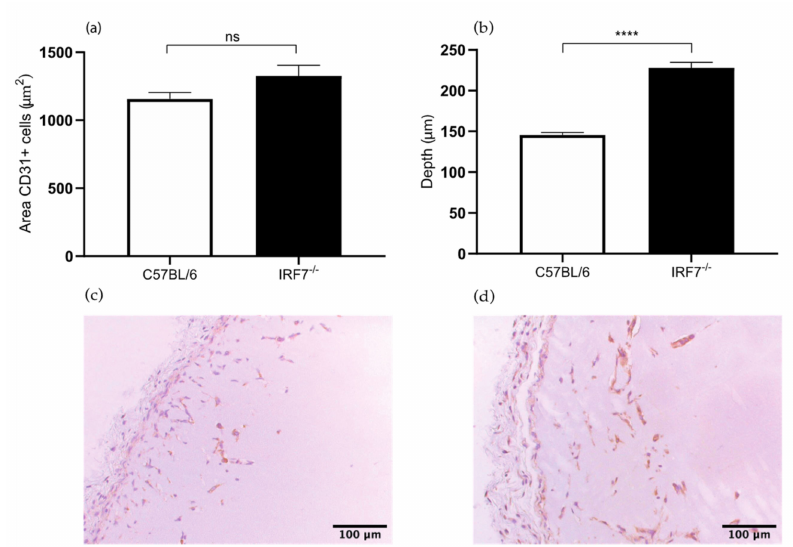
Figure 2. ( a ) Area of CD31 + cells in the subcutaneously injected Matrigel, in IRF7 − / − and wild type C57BL/6 mice. ( b ) Quantification of the depth ( µ m) of ingrowth of CD31 + cells into subcutaneously injected Matrigel, in IRF7 − / − and wild type C57BL/6 mice. ( c ) Immunohistochemical staining of paraffin-embedded Matrigel plug of C57BL/6 7 days after Matrigel injection, using anti-CD31 antibodies. ( d ) Immunohistochemical staining of paraffin-embedded Matrigel plug of IRF7 − / − mice 7 days after Matrigel injection, using anti-CD31 antibodies. N = 6 mice per group, 2 Matrigel plugs per mouse. Values are presented as the mean SEM. ns not significant. **** p ≤